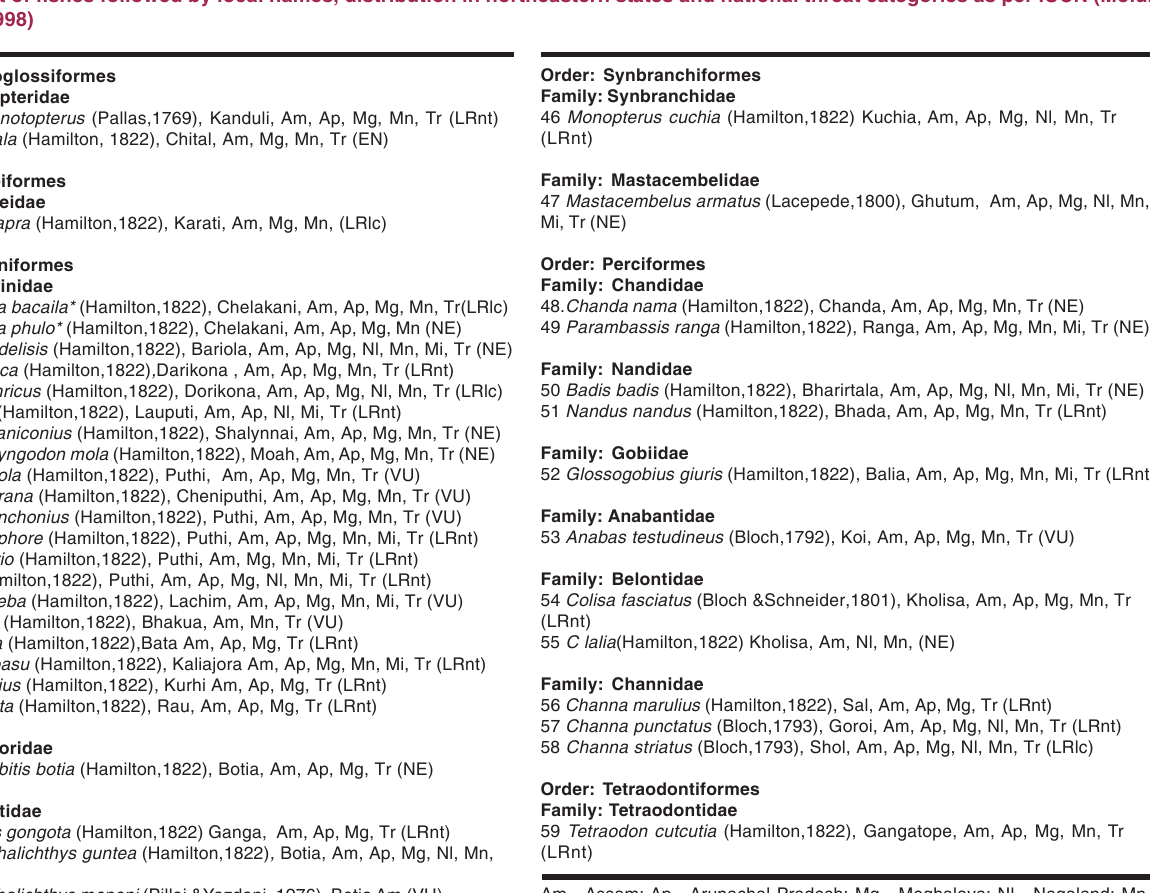
Table 1. List of fishes followed by local names, distribution in northeastern states and national threat categories as per IUCN (Molur & Walker